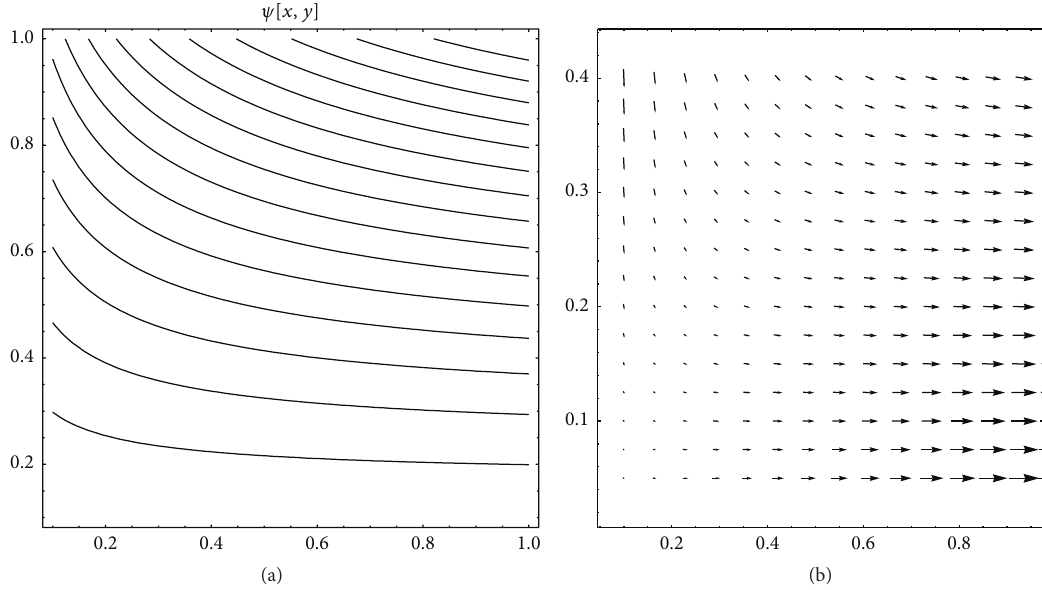
Figure 8: Development of (a) stream function and (b) velocity vector field for Newtonian fluid boundary layer ( 𝐶 = 0 ) [28].